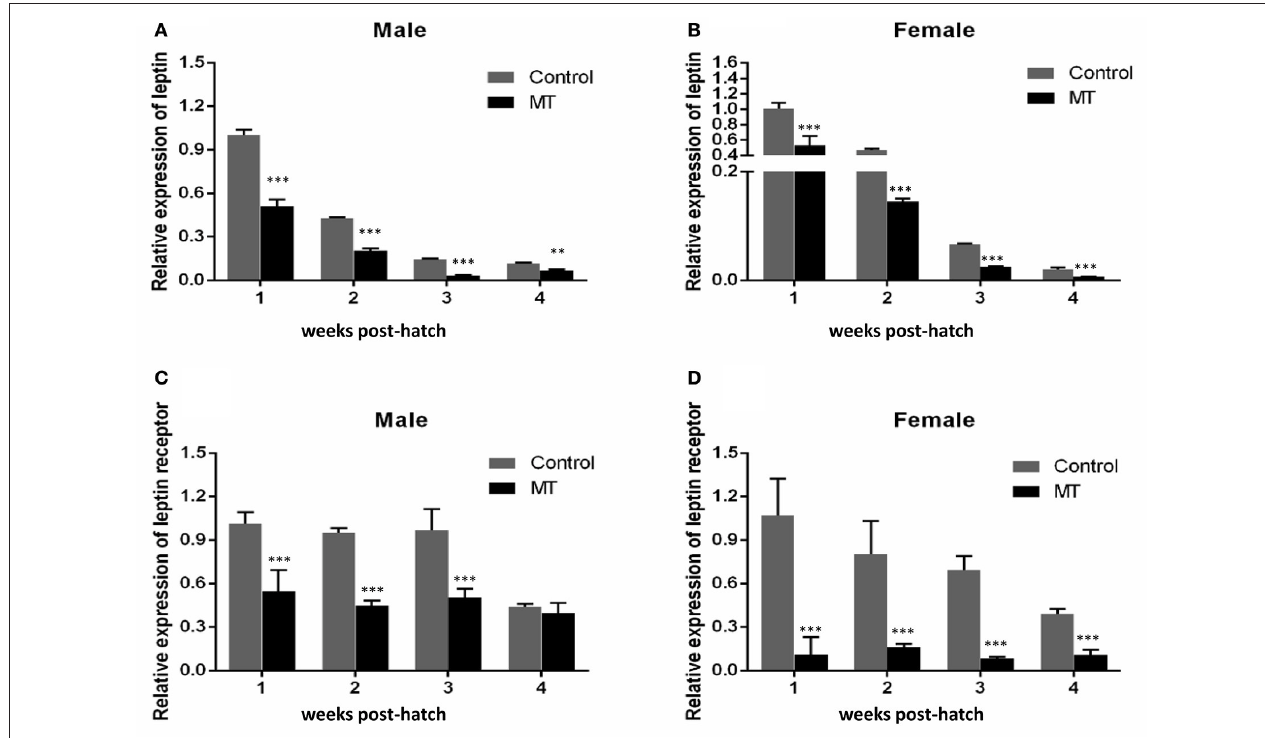
FIGURE 5 | Effects of MT on the expression of lep and lepr mRNA during juvenile growth in male and female yellow catfish. (A–D) showed the expression of lep and lepr mRNA respectively. MT, MT treatment group; Control, control group. The asterisk indicates the significant differences of gene expression between the females and males (** P < 0.01 and *** P < 0.001).